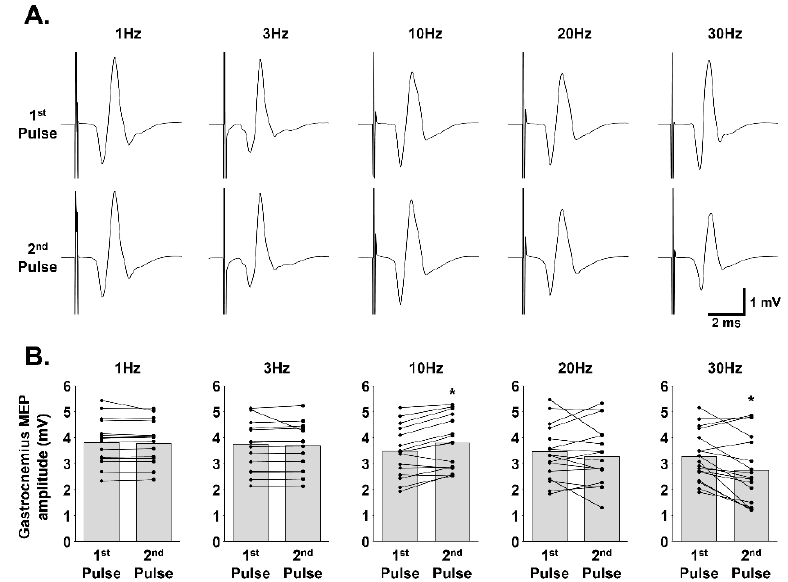
Figure 3. Neuromuscular response to magnetic stimulations delivered at different frequencies: ( A ) Representative traces of gastrocnemius motor evoked potentials (MEP) for the first and the second pulses delivered at 1 Hz, 3 Hz, 10 Hz, 20 Hz and 30 Hz (90% MO). ( B ) Corresponding MEP quantification. * 1st pulse compared to 2nd pulse (paired t test, p ≤ 0.001).